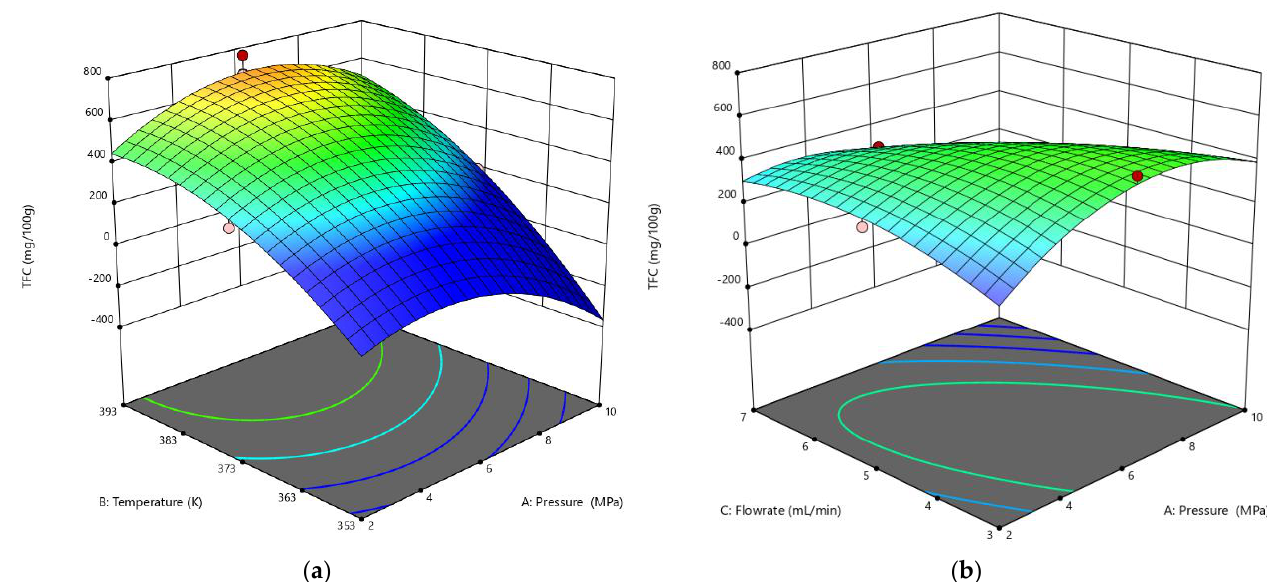
Figure 6. The 3D response of the effects of variables on the total phenolic compounds (TFC) (mg/100 g) at ( a ) a constant flow rate of 5 mL/min and ( b ) a temperature of 393 K.